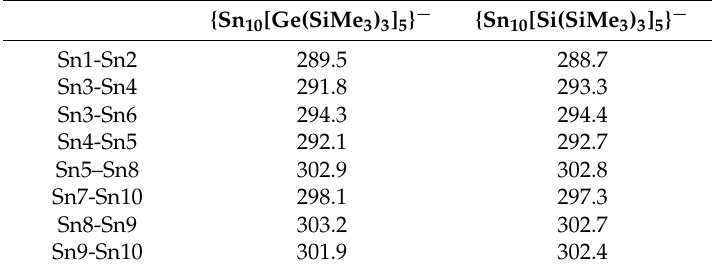
Table 3. Comparison of the bond lengths in pm of the metalloid clusters {Sn 10 [Ge(SiMe 3 ) 3 ] 5 } – and {Sn 10 [Si(SiMe 3 ) 3 ] 5 } –